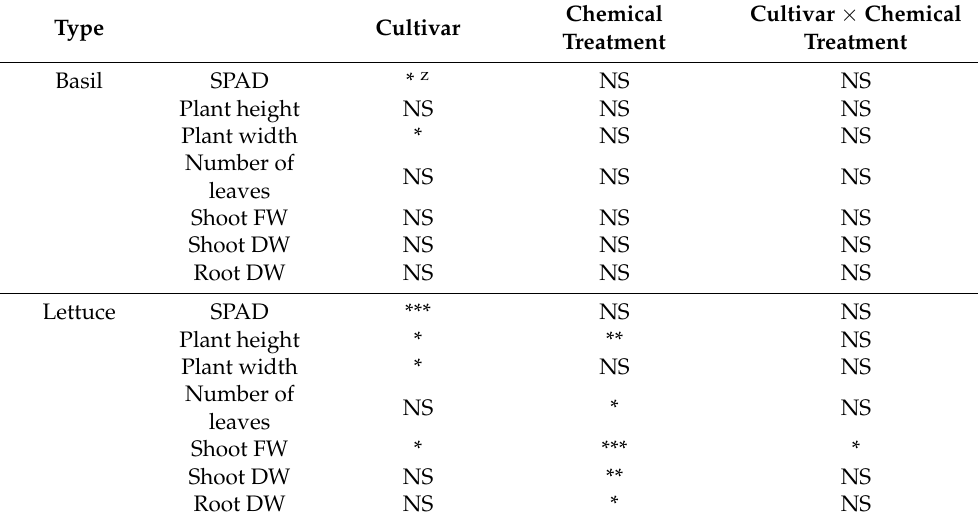
Plant width NS NS Number